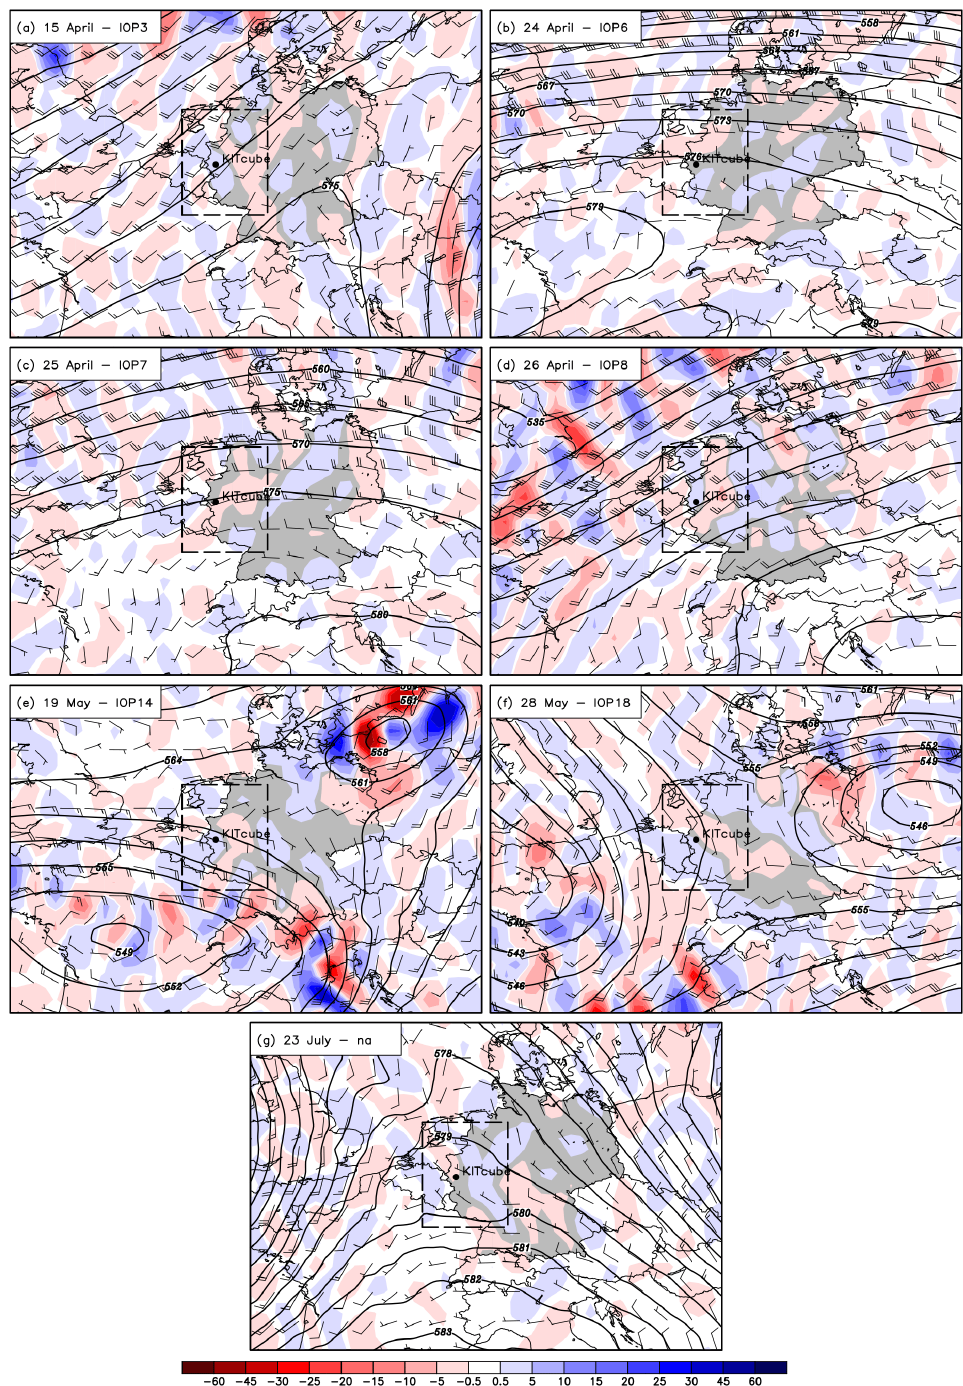
Figure 2. COSMO-EU analyses for 12:00UTC showing 500hPa geopotential height (gpdm, contours), Q vector divergence (10 − 17 m ( kgs ) − 1 , shading), and horizontal wind (knots). Red colors indicate forcing for upward motion and blue colors for downward motion. The dashed black rectangle indicates the common investigation